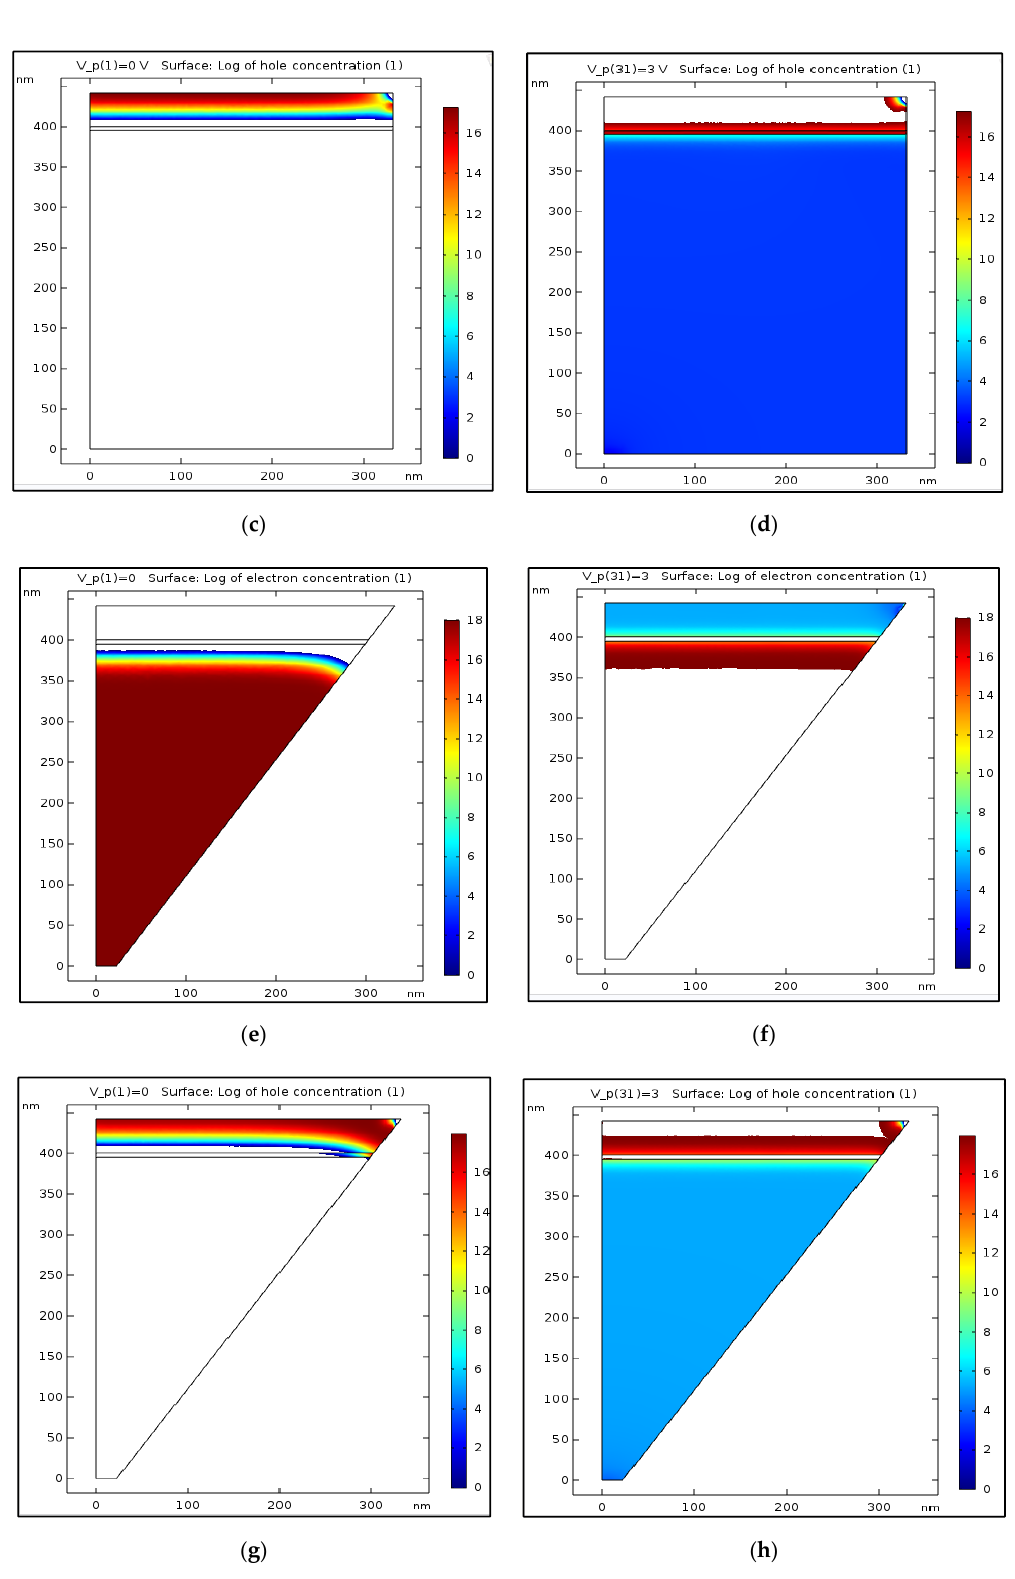
Figure 4. 2D simulations of electrons and holes concentration in cylindrical shape (LED) at equilibrium (no voltage bias) and at 3 V. Color Log distribution scale in cm − 3 . T = 300 K, λ = 450 nm, E gap = 2.75 eV. Two-dimensional LED: ( a ) electrons, V = 0 V; ( b ) electrons, V = 3 V; ( c ) holes, V = 0 V; ( d ) holes, V = 3 V. Two-dimensional LENS: ( e ) electrons, V = 0 V; ( f ) electrons, V = 3 V; ( g ) holes, V = 0 V; ( h ) holes, V = 3